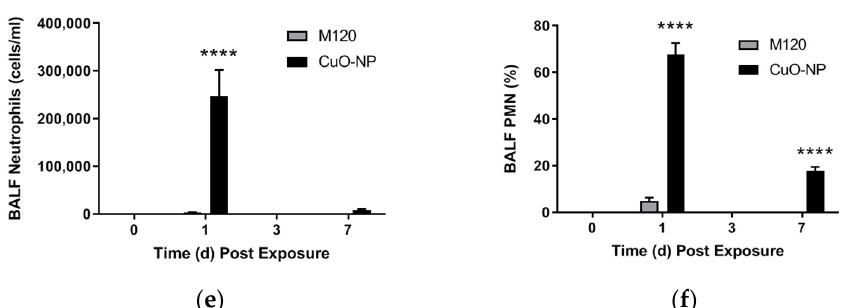
Figure 2. Kinetics of CuO-NP-induced Lung Injury in Mice. ( a ) representative clinical image of murine lungs extracted 4 h following intranasal administration of 15 µg CuO-NPs; ( b ) representative H & E section of a mouse lung 1 h following CuO-NP exposure ( c ) kinetics of BALF WBCs; ( d ) kinetics of BALF protein levels; ( e ) kinetics of BALF PMNs; ( f ) kinetics of BALF percent PMN determined 0, 1, 3, and 7 days post-CuO-NP or M120 exposure. All data are presented as the mean ± the standard error of the mean ( n = 3–7 per group per time point). Asterisks indicate a statistically significant difference (* p < 0.05 and **** p < 0.0001) from their respective time 0.